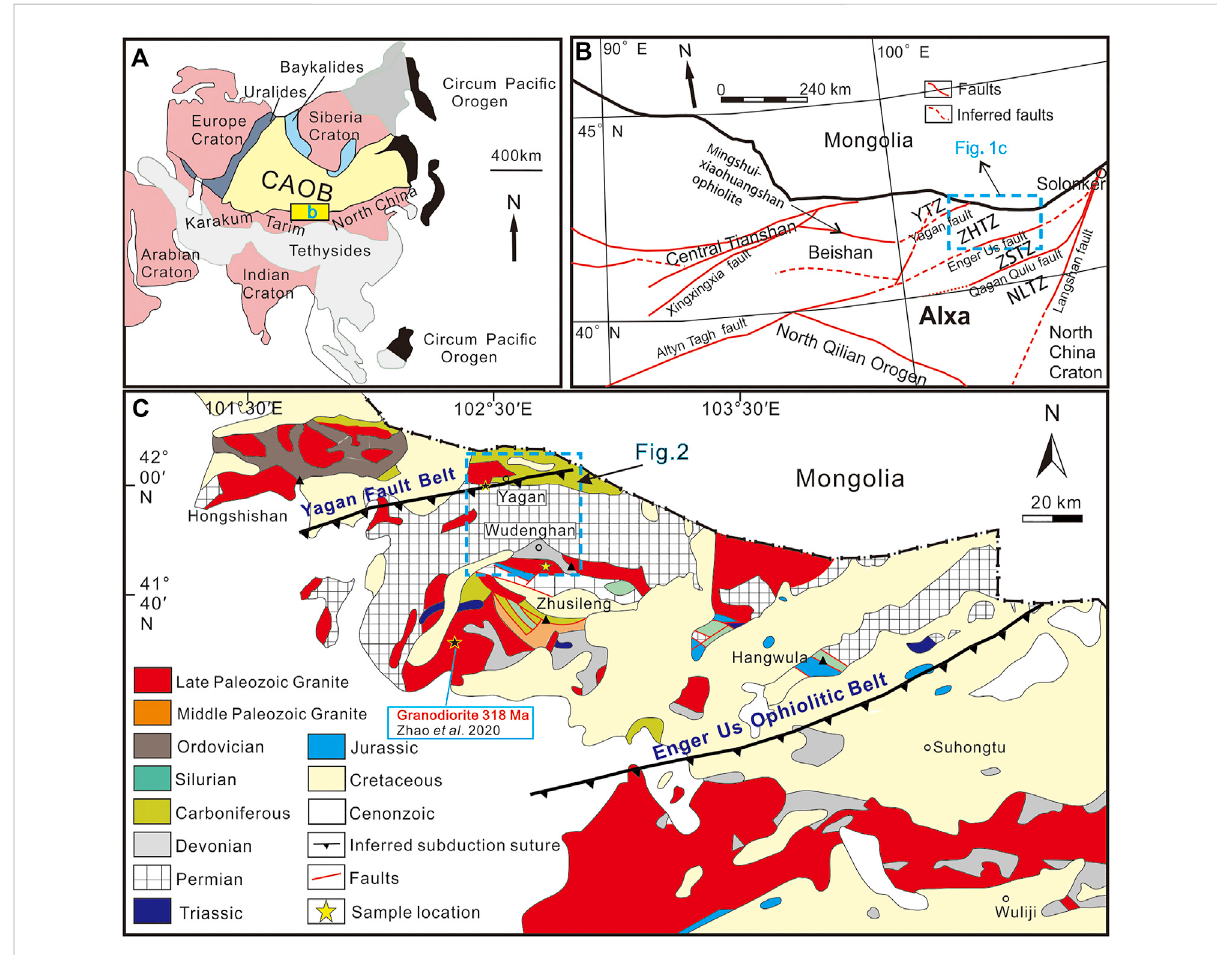
FIGURE 1 (A) GeologicalmapoftheCentralAsianOrogenicBelt(modi fi edafterJahnetal.,2000). (B) TectonicunitsofAlxablock(modi fi edafterWu&He, 1993). (C) GeologicalmapofthenorthernAlxaregion(modi fi edafterShietal.,2011).YTZ:Yagantectoniczone,ZHTZ:Zhusileng-Hangwulatectonic zone, ZSTZ: Zongnaishan-Shalazhashan tectonic zone, NLTZ: Nuru-Langshan tectonic